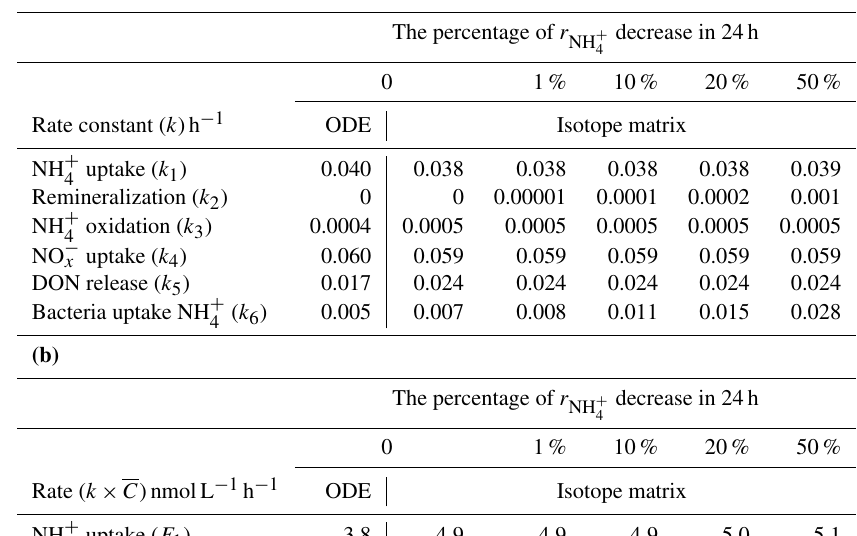
Table 1. The isotope matrix results for (a) the specific rates and (b) average rates of N processes in the low-nutrient case during the first interval under different r variation conditions. In addition, all N transformation rates via ODE following Pfister et al. (2016) on the NH + 4 assumption of no remineralization were estimated for comparison. Note: r variation was manipulated artificially by decreasing r NH + 4 values at a constant reduction rate and the total reduction of r was 0, 1, 10, 20, and 50% of the full time span (24h) of NH + 4